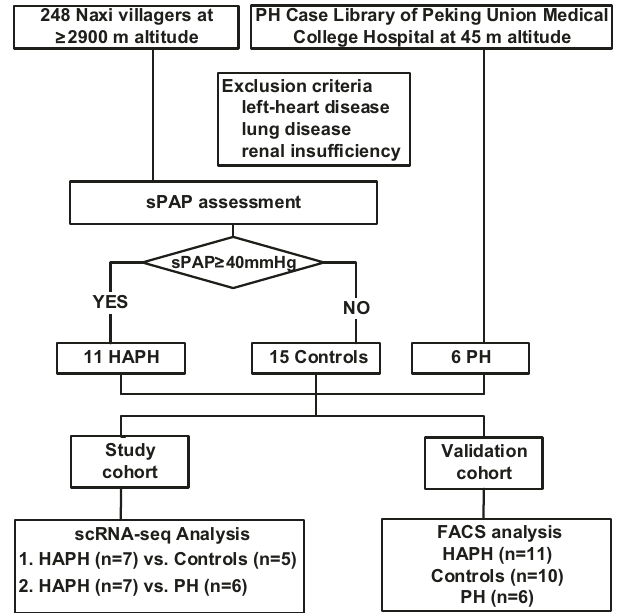
Fig.1|Flowchartofstudydesign. Intotal,11patientswithsPAP ≥ 40mmHgand15 controls who lived at the ≥ 2900m altitude, 6 PH cases living at 45m altitude were enrolled. scRNA-seq analysis was performed comparing between 7 HAPH and 5 controls, and also between 7 HAPH and 6 PH, followed by validation carried out among 6 PH, 11 HAPH and 10 controls with FACS analysis. PH pulmonary hyper- tension, HAPH high-altitude pulmonary hypertension, sPAP systolic pulmonary artery pressure, scRNA-seq single-cell RNA sequencing, FACS fl uorescence- activated cell